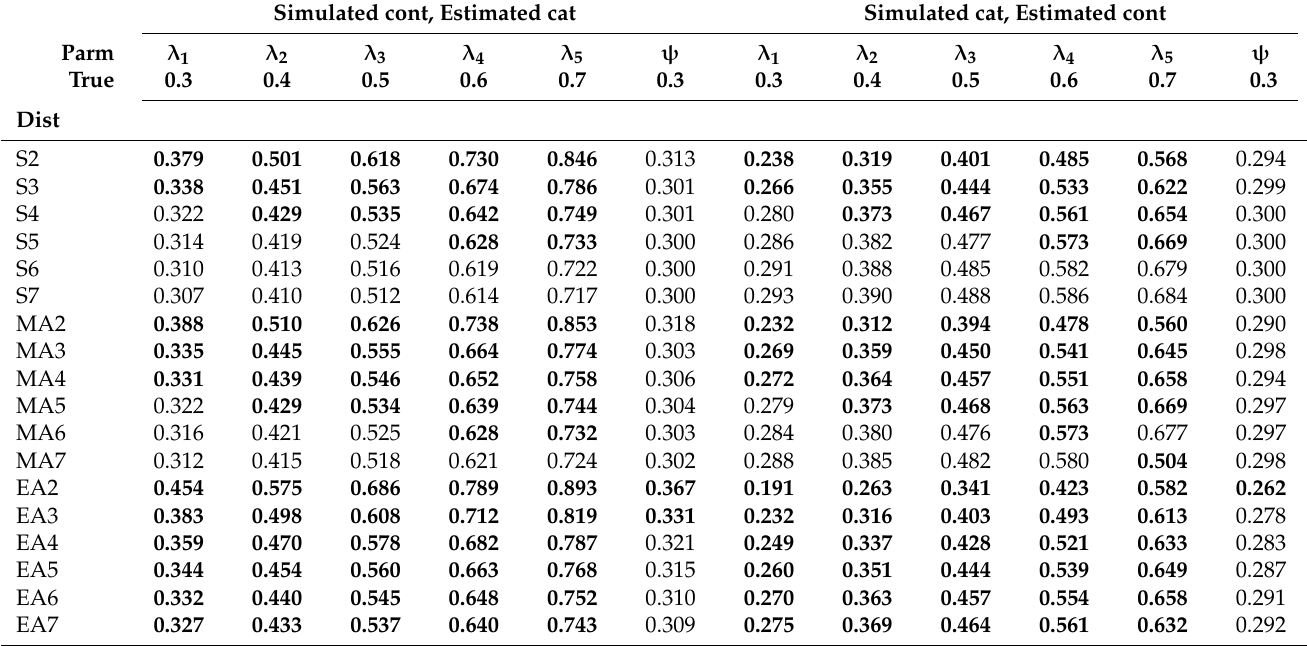
Table 3. Simulation Study 2: Estimated factor loadings λ 1 , . . . , λ 5 and factor correlations ψ as a function of data-generating models and estimation